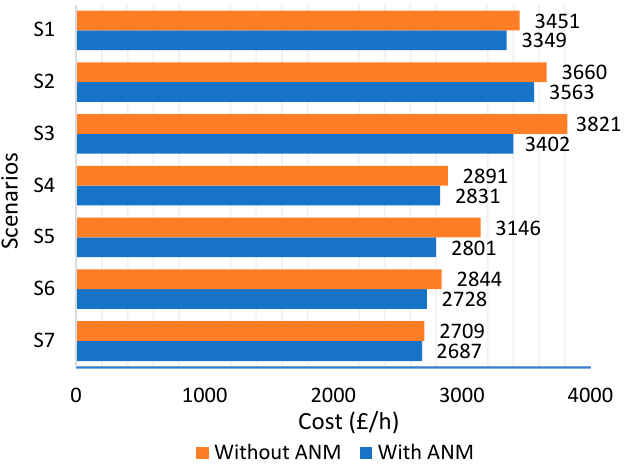
Figure 6. Overall network operating cost comparison for network planning with and without ANM.